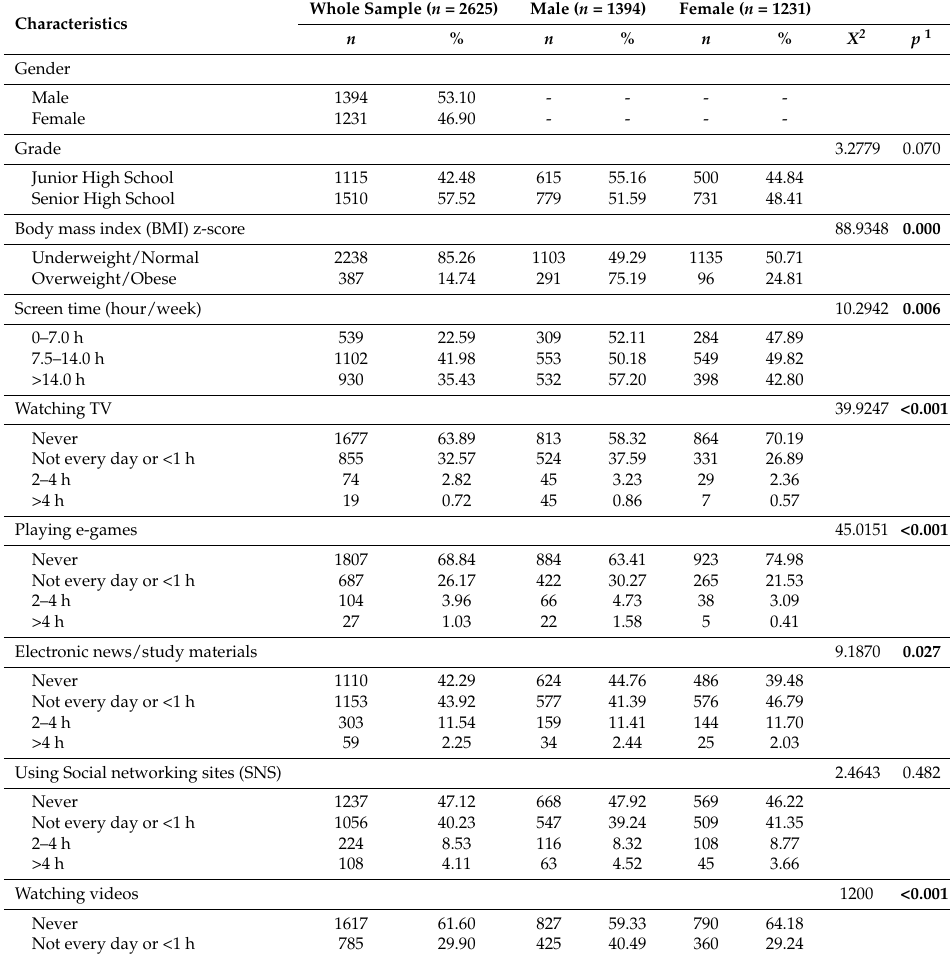
Table 1. Demographic characteristics of participating youth ( n = 2625) and Chi-square analyses by gender for all dependent